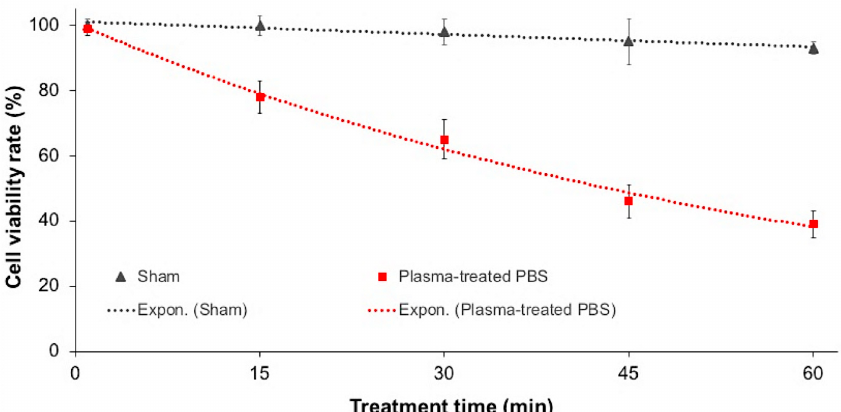
Figure A1. Cytotoxicity of pPBS to adherent DC-3F cells. Survival curves of DC-3F cells that were plated immediately after being incubated with pPBS between 1 and 60 min. are presented as the number of viable colonies formed five days after the treatment. Results from three independent experiments (each in triplicate) are shown as mean values ± SD for each parameter set.